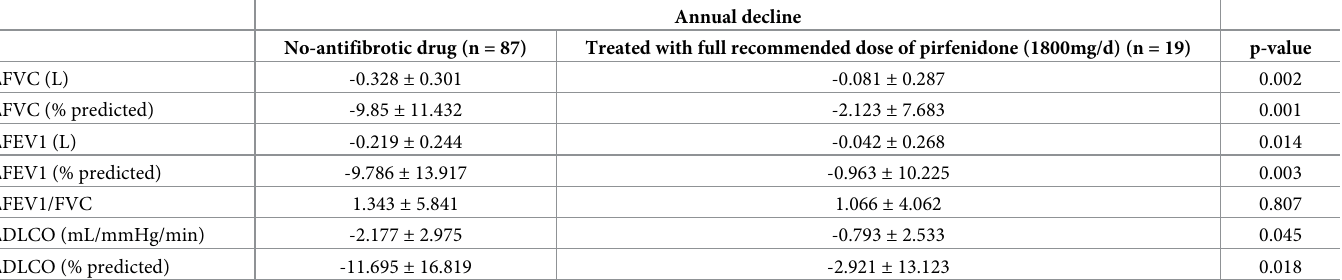
Table 5. Comparison of annual decline in pulmonary function between patients who were not treated with antifibrotic drugs and patients who were treated with full recommended dose of pirfenidone